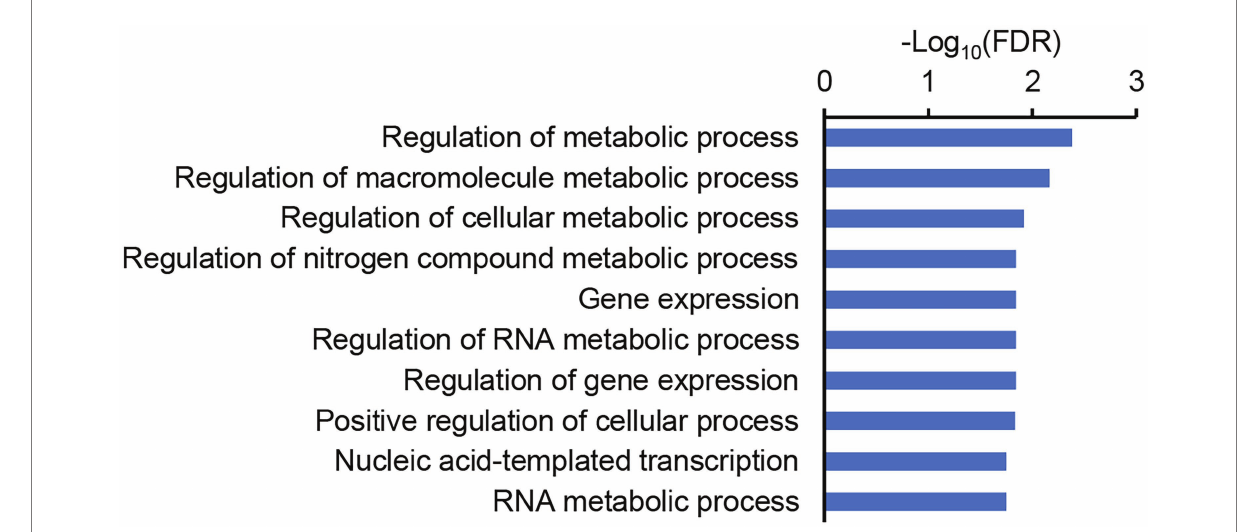
FIGURE 8 The GO enrichment of the co-expressed genes of OsbZIP59 . The top-10 GO enriched items of biological process are shown, and the false discovery rate (FDR) is log 10 -transferred. The full results of the GO enrichment are provided in Supplementary Table